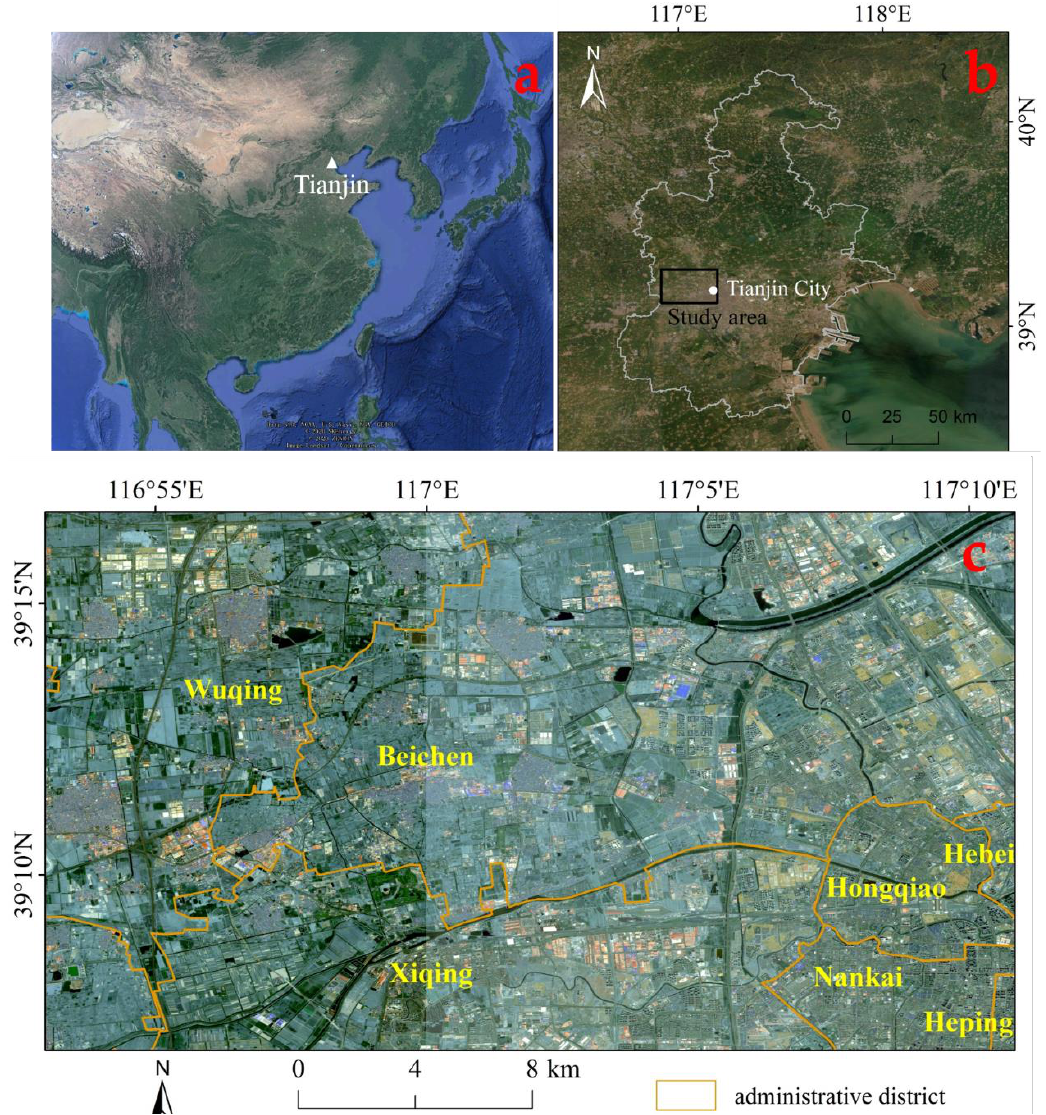
Figure 1. ( a ) Location of Tianjin city from the Google Earth map; ( b ) the study area outlined by a black rectangle; ( c ) administrative districts of the study area with the background of Sentinel-2A images acquired in 2018.